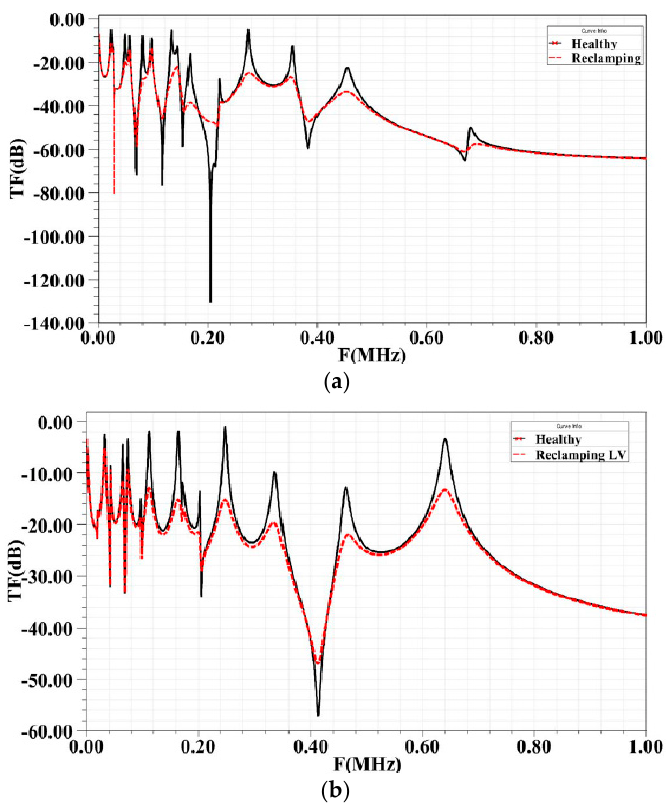
Figure 5. Impact of clamping fault on: ( a ) the HV FRA signature; and ( b ) the LV FRA signature [15].